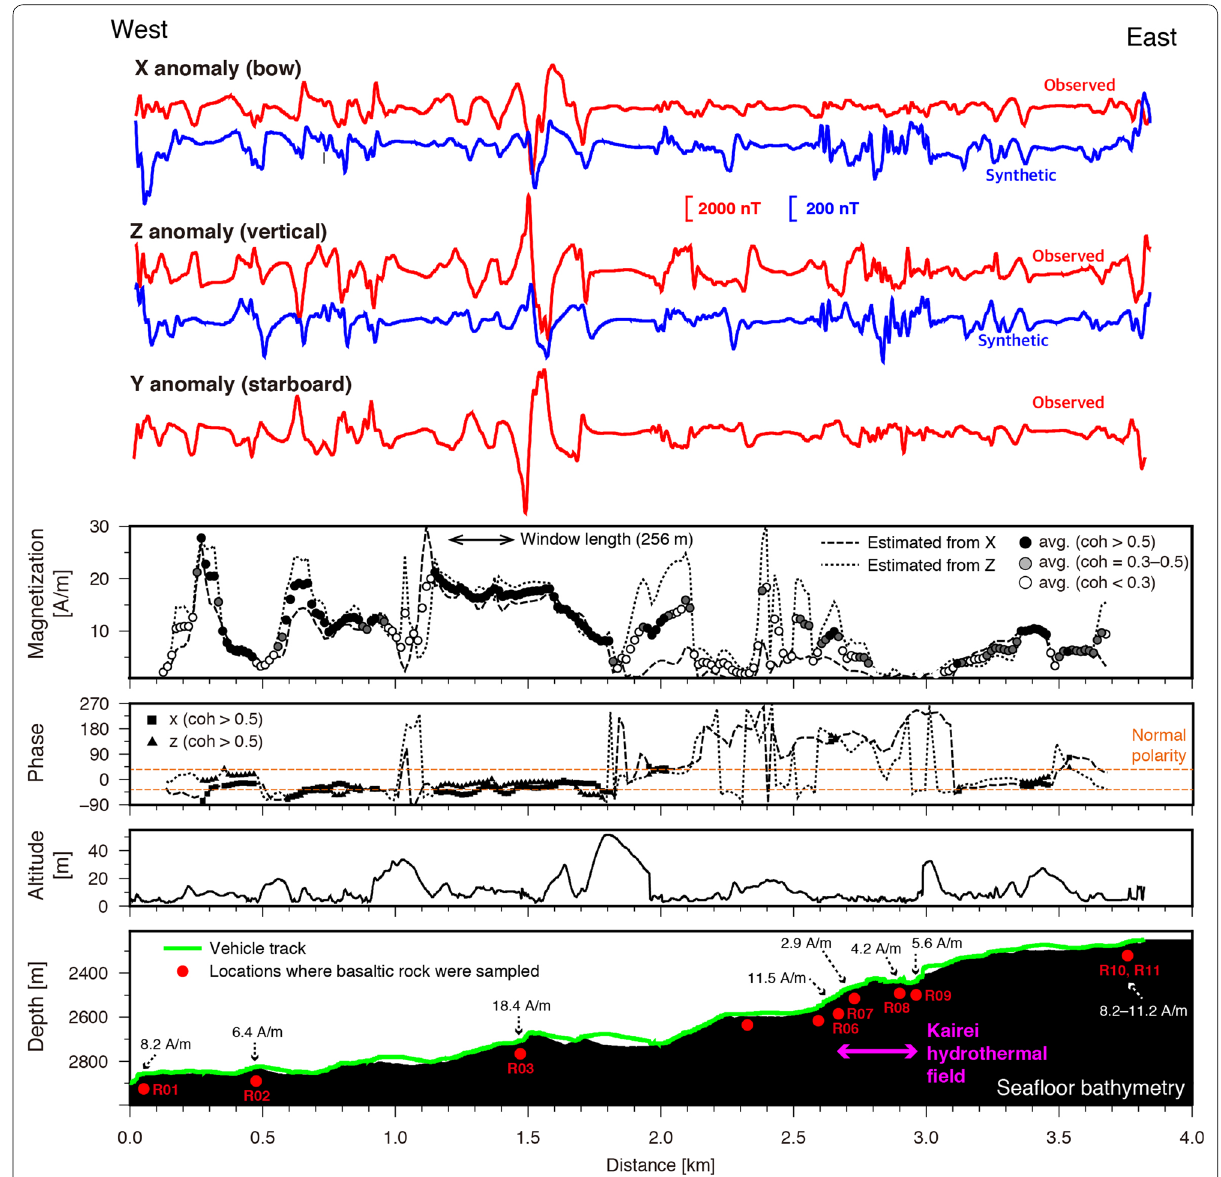
Fig. 3 Analysis x (bow) and z (downward) components of observed magnetic anomaly along the 6K#918 track. From top to bottom: observed (red line) and synthetic (blue line) magnetic anomaly intensity, magnetization, phase, vehicle altitude, and seafloor/vehicle geometry. Black and gray circles are those with high coherency of > 0.5 and from 0.3 to 0.5 on both the x and z components, respectively. The location of the Kairei hydrothermal field and collected basaltic rock samples are shown in the bottom figure. Major element composition for lava samples of 918R02, 918R02, and 918R10 is shown in Additional file 5: Table